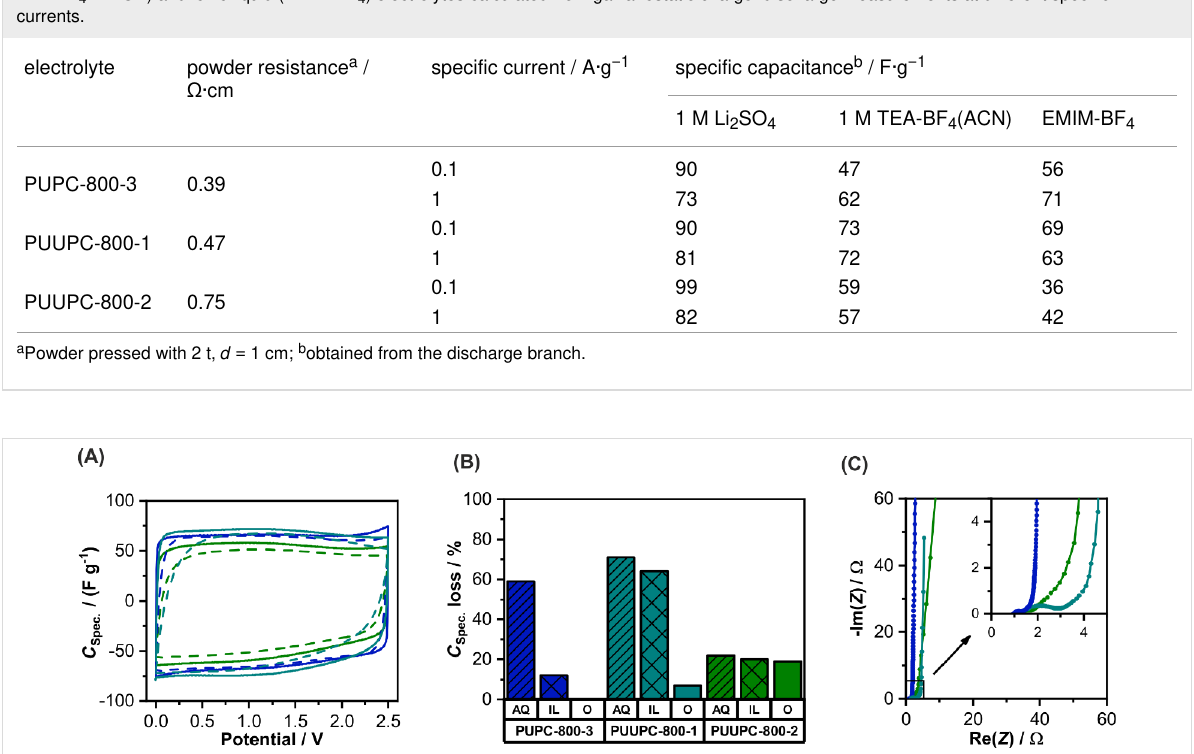
Table 2: Electrochemical characterization data of PUPC-800-3, PUUPC-800-1 and PUUPC-800-2 measured in aqueous (1 M Li 2 SO 4 ), organic (1 M TEA-BF